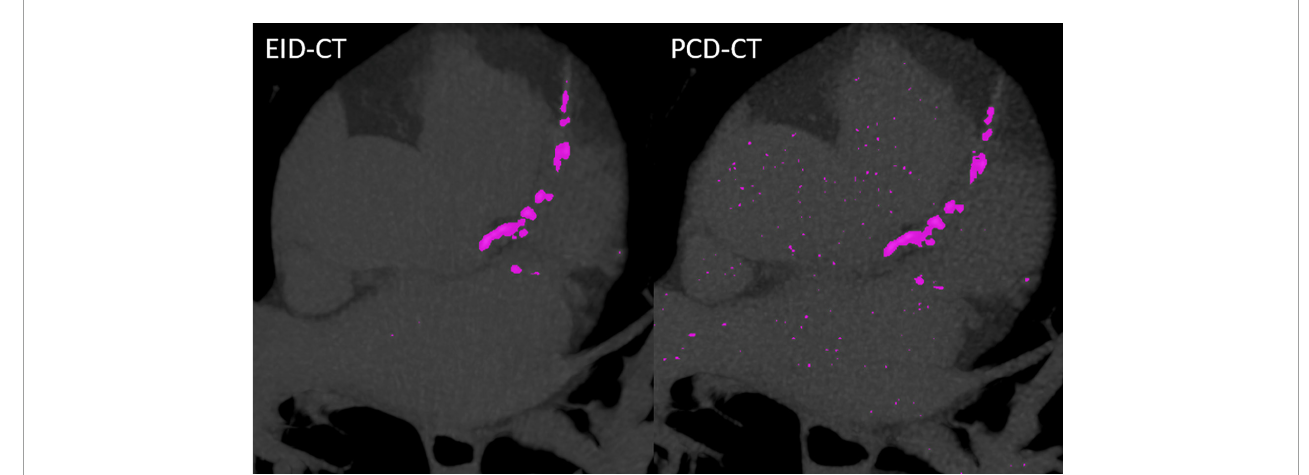
FIGURE3 Phantom study comparing CACS (A,C) and CAC volume (B,D) between PCD-CT and EID-CT in scatter- (A,B) and Bland-Altman plots (C,D) . SD, standard deviation; r , Spearmen correlation.